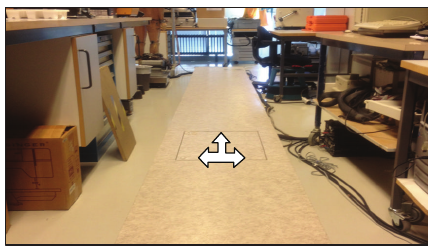
Figure 4: Force plate installed in laboratory